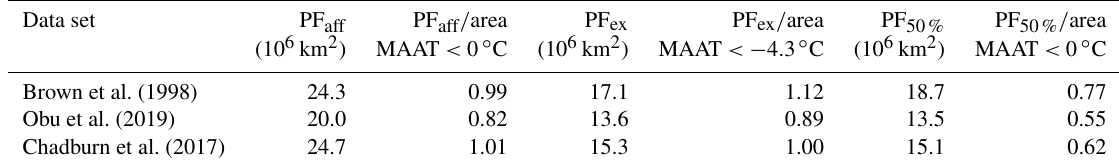
Table 2. Permafrost areas from three of the available observational data sets defined both as an areal extent and as a fraction of the area where the observed MAAT is below the given threshold. PF aff is defined as the permafrost-affected area and includes any grid cells which have a non-zero probability ( > 1%) of permafrost occurrence. PF ex is the area of permafrost weighted by the proportion of permafrost in each grid cell, and PF 50% is the area where the probability of finding permafrost is ≥ 50%. The Chadburn et al. (2017) relationship has a 50% chance of the presence of permafrost at − 4.3 ◦ C. MAAT is the mean for the period 1995 to 2014. Data set PF aff PF aff / area PF ex PF ex /